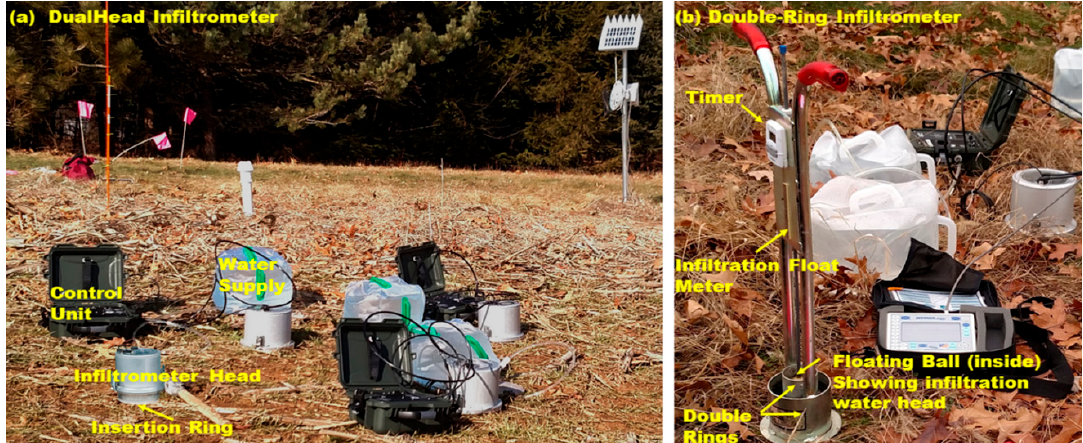
Figure 2. ( a ) Dualhead infiltrometers (DHIs) during a measurement (in triplicate) on the irrigated cropland, and ( b ) double-ring infiltrometer (DRI) during a measurement alongside a dualhead infiltrometer on the non-irrigated cropland.